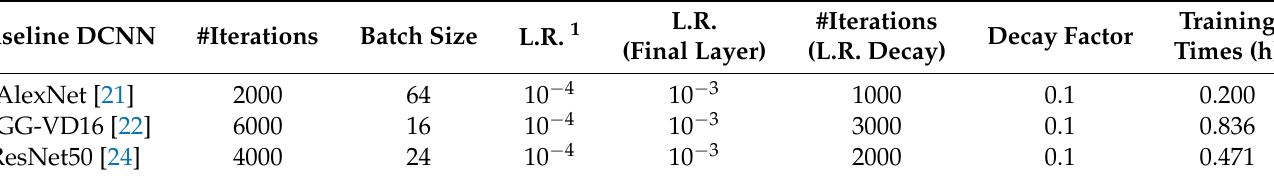
Table 1. Parameters utilized for models with different baseline deep convolutional neural networks (DCNNs) on the UC data